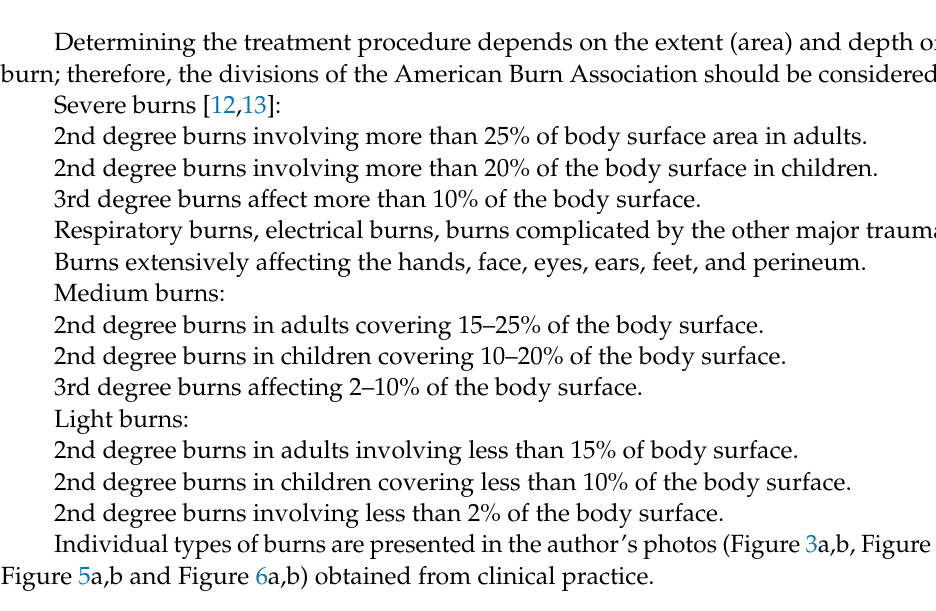
Figure 2. Characteristics of burns [10,11].